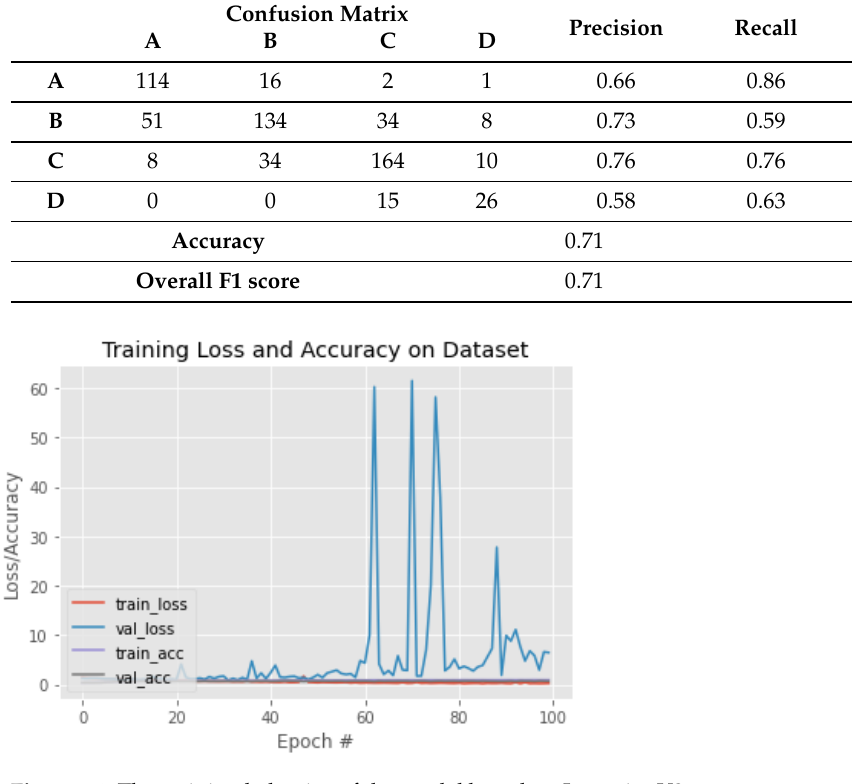
Figure 14. The training behavior of the model based on